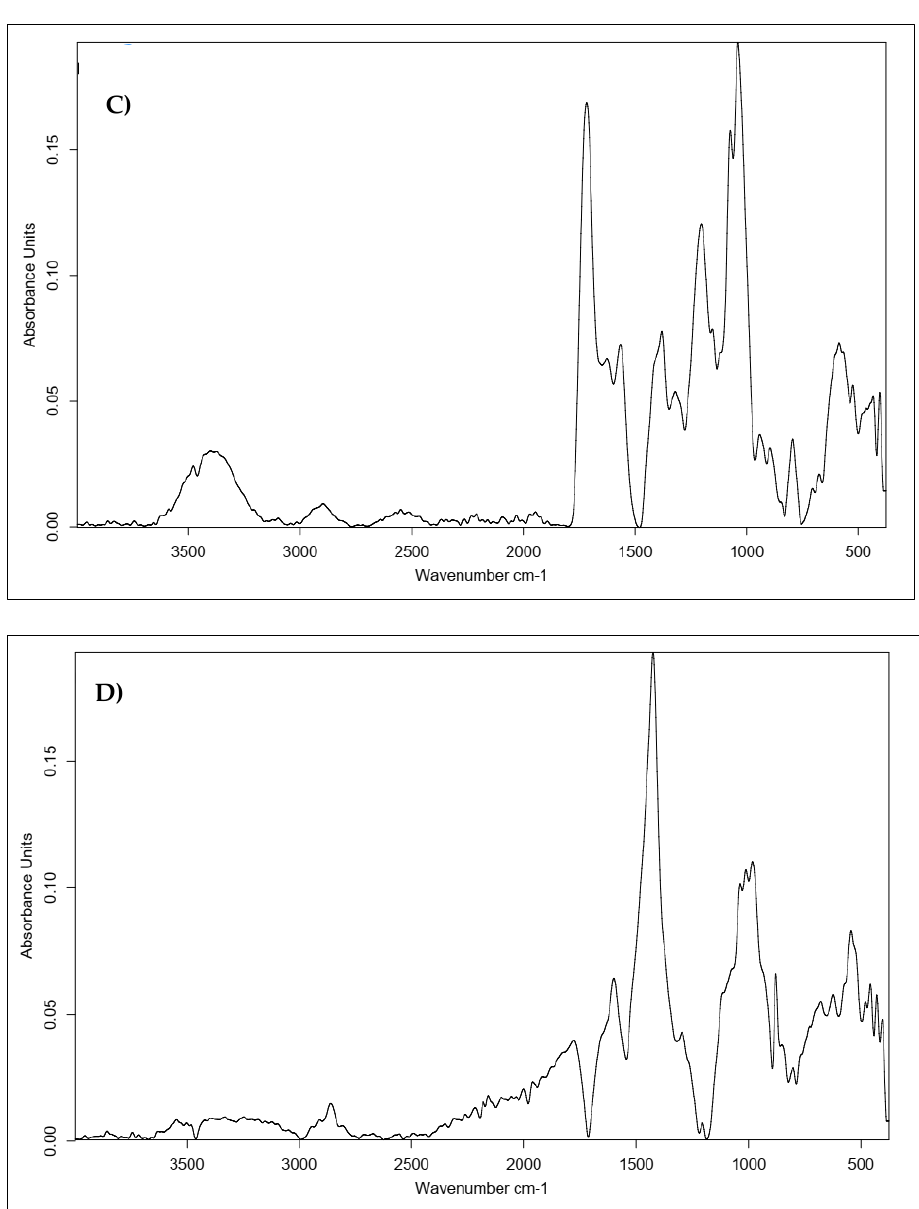
Figure 24. Comparison of the IR spectra obtained for the materials coated with mixture of hyaluronic acid H-FFPLADDVTP-OH and cross-linked with different cross-linking agents. Approach: layer-by-layer physical modification. ( A ) With 0.5% HA, 20 mg of peptide and 20% CA; ( B ) 1% HA, 20 mg of peptide, and 20% CA; ( C ) 2% HA, 20 mg of peptide, and 5% CA; ( D ) 1% HA, 20 mg of peptide, and BDDE.